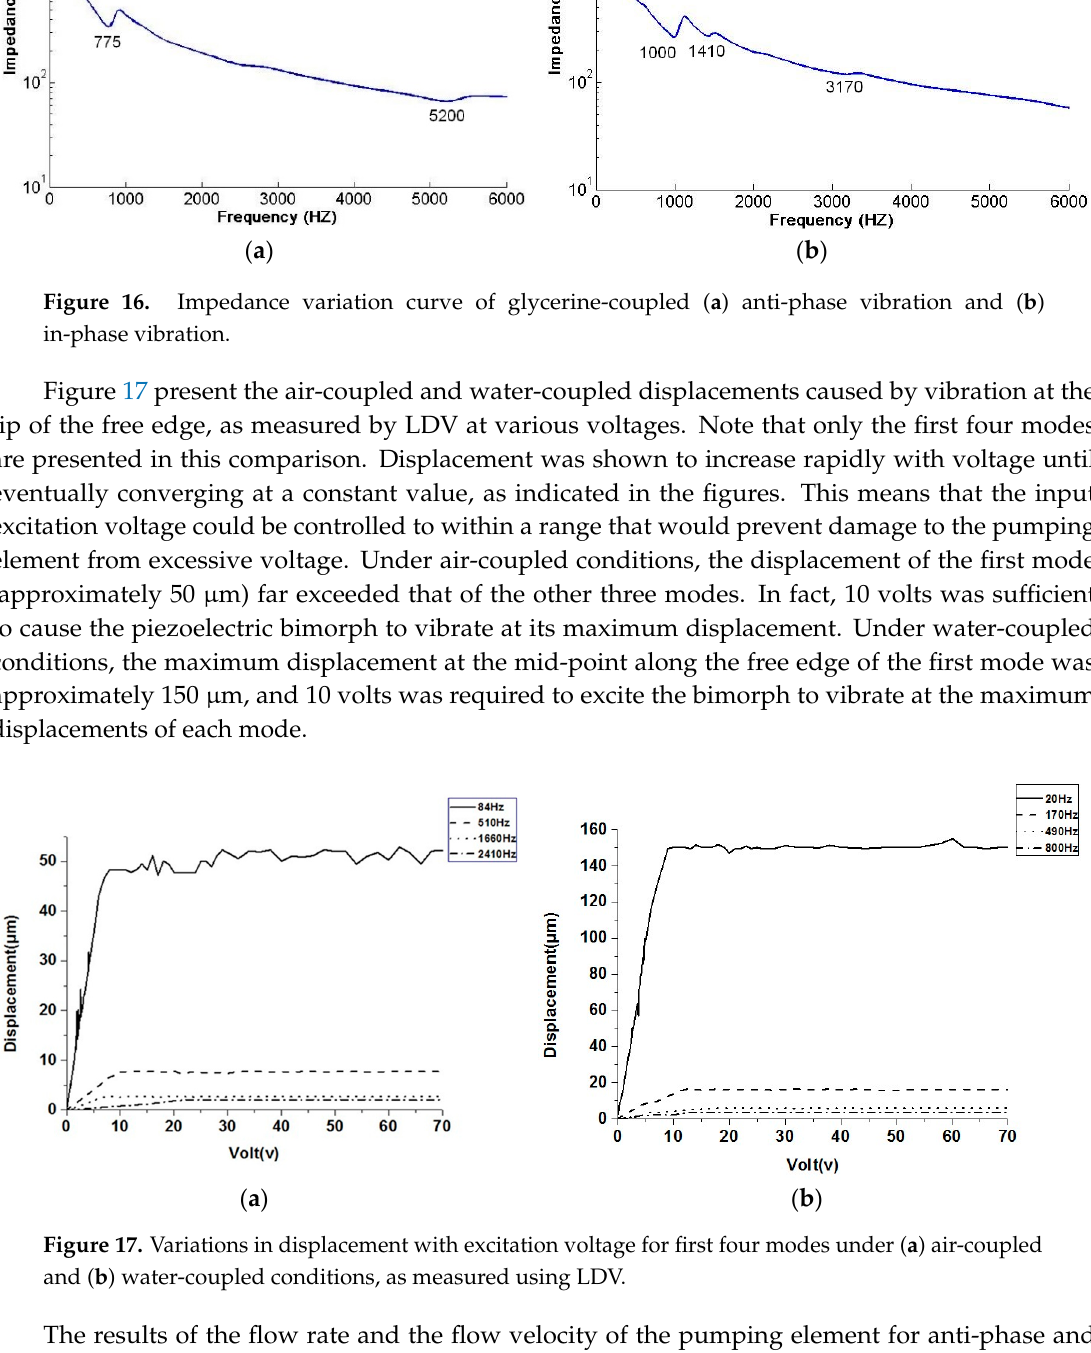
coupled and ( b ) water-coupled conditions, as measured using LDV.